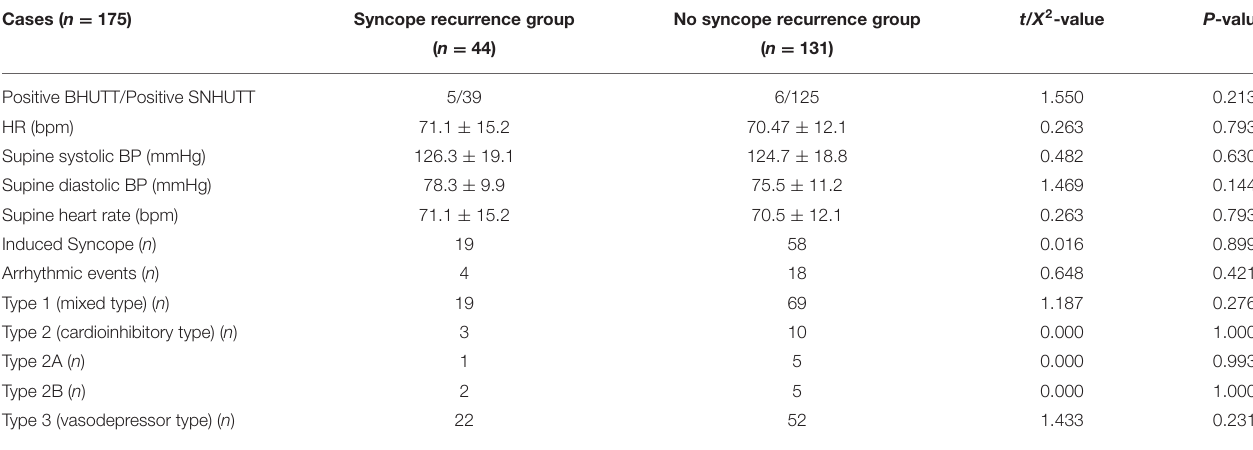
TABLE 2 | Baseline positive HUTT characteristics of the study